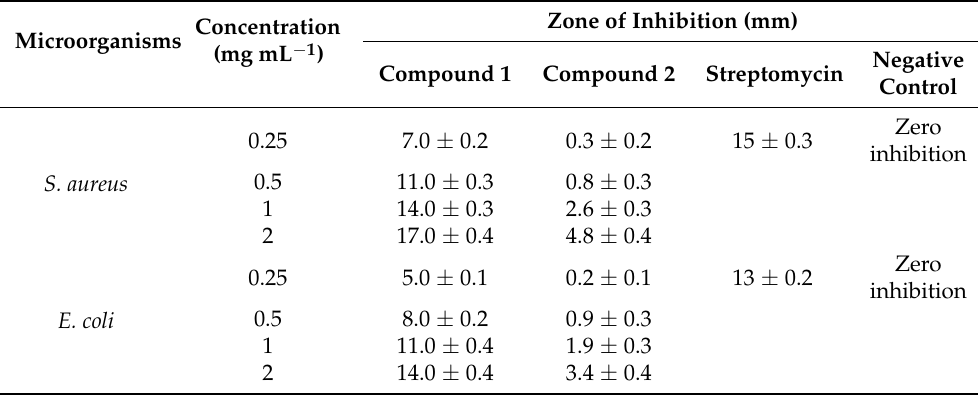
Table 3. Zone of inhibition of compound 1 and standard drug against tested